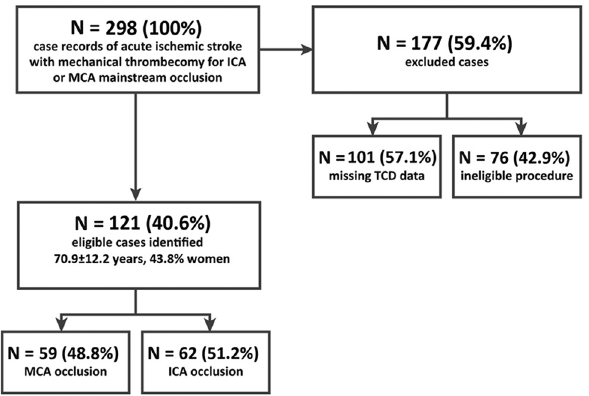
Figure 2: Flowchart schematic of included and excludes cases in this retrospective